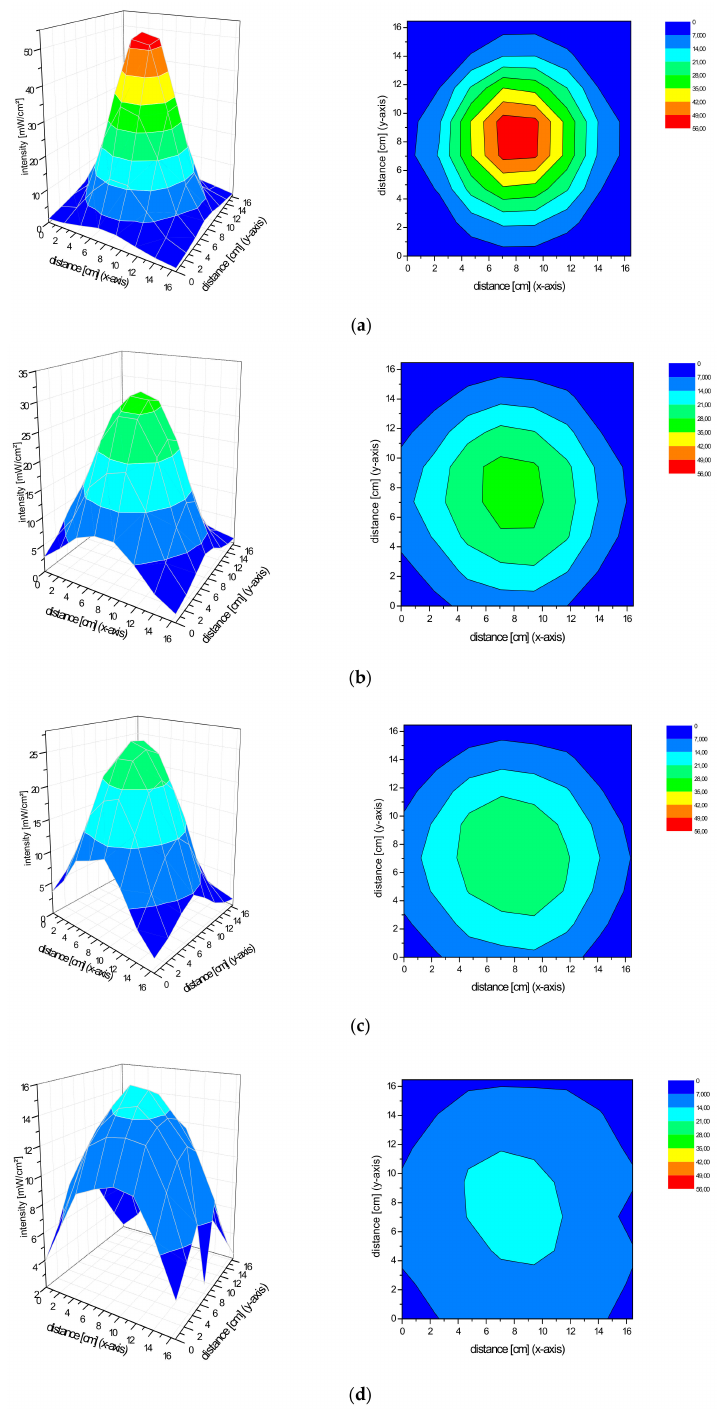
Figure 3. ( a ) Irradiance distribution of the Repuls7PDI-red at a distance of 10 cm. The device was fixed with a tripod with the radiating surface parallel downwards to the measuring plane. ( b ) Irradiance distribution of the Repuls7PDI-red at a distance of 13.5 cm. The device was fixed with a tripod with the radiating surface parallel downwards to the measuring plane. ( c ) Irradiance distribution of the Repuls7PDI-red at a distance of 15 cm. The device was fixed with a tripod with the radiating surface parallel downwards to the measuring plane. ( d ) Irradiance distribution of the Repuls7PDI-red at a distance of 20 cm. The device was fixed with a tripod with the radiating surface parallel downwards to the measuring